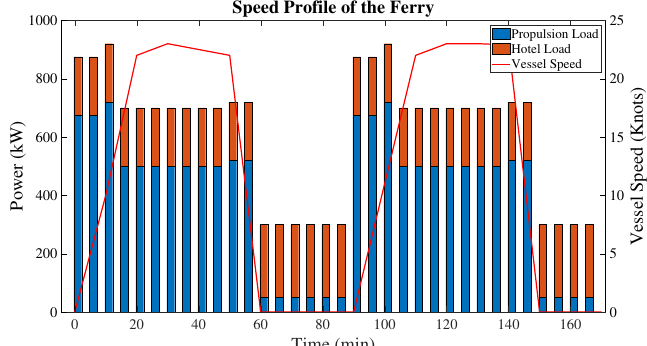
Figure 5. Typical Speed and Load Profile of the